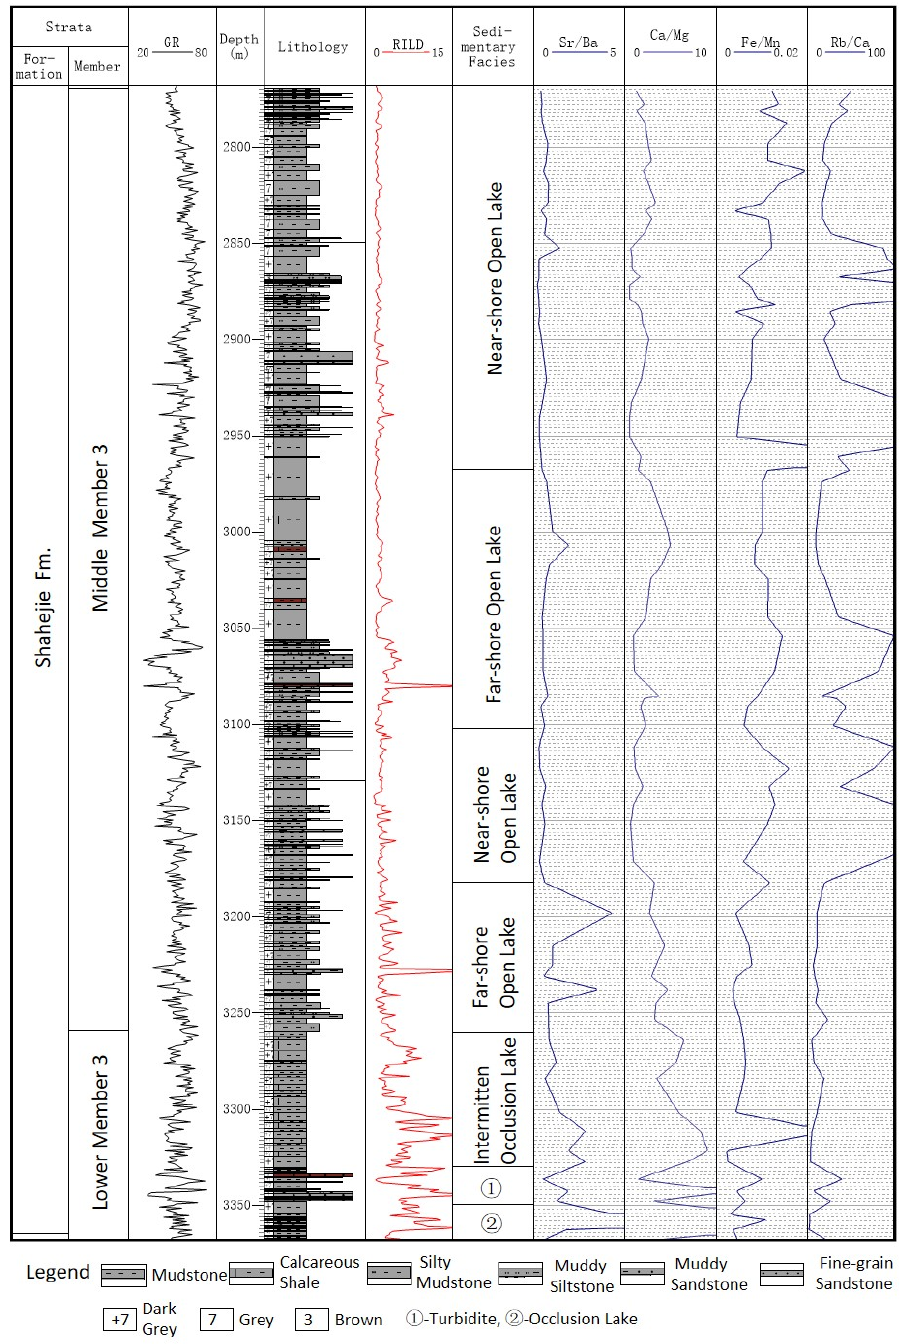
Figure 1. Longitudinal variation of element ratio in Well Niu 38, Dongying Depression.